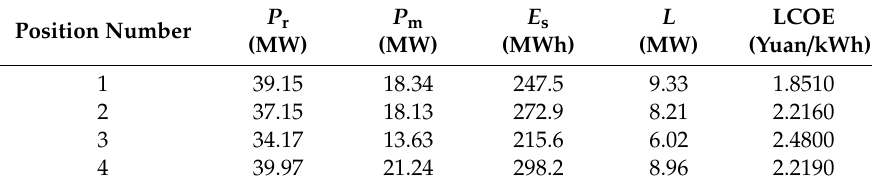
Table 6. Optimal sizing results (1 day continuing the power